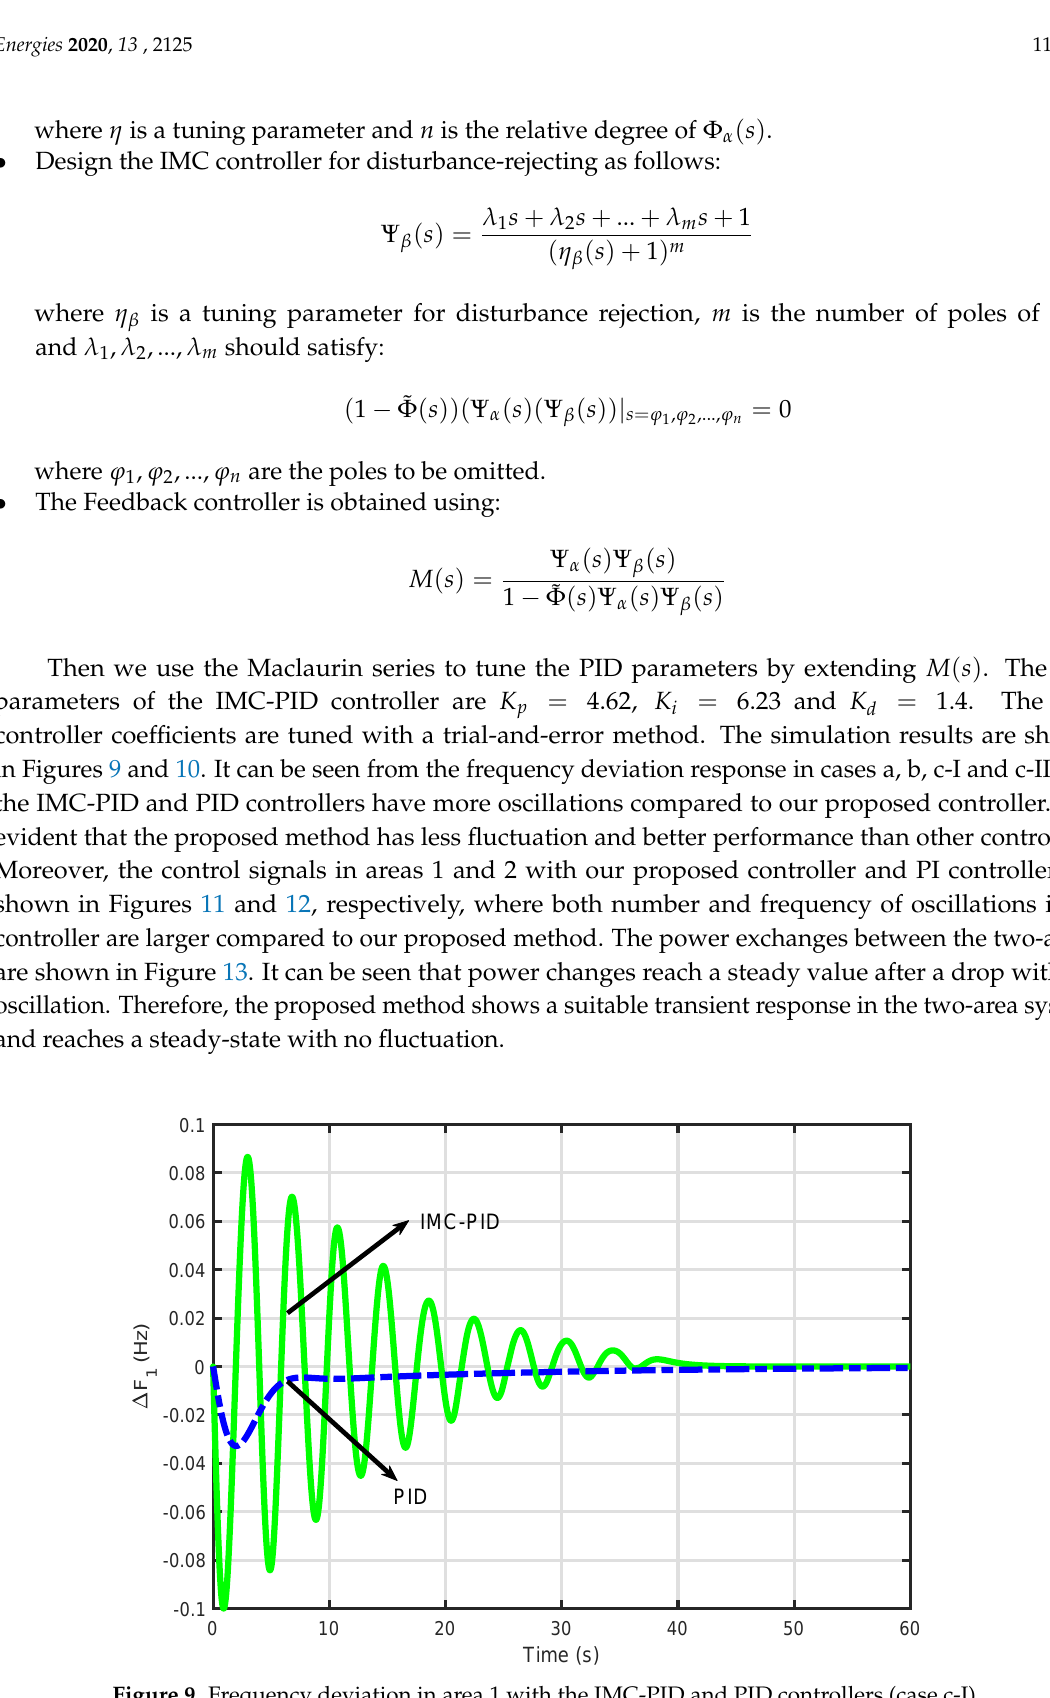
Figure 9. Frequency deviation in area 1 with the IMC-PID and PID controllers (case